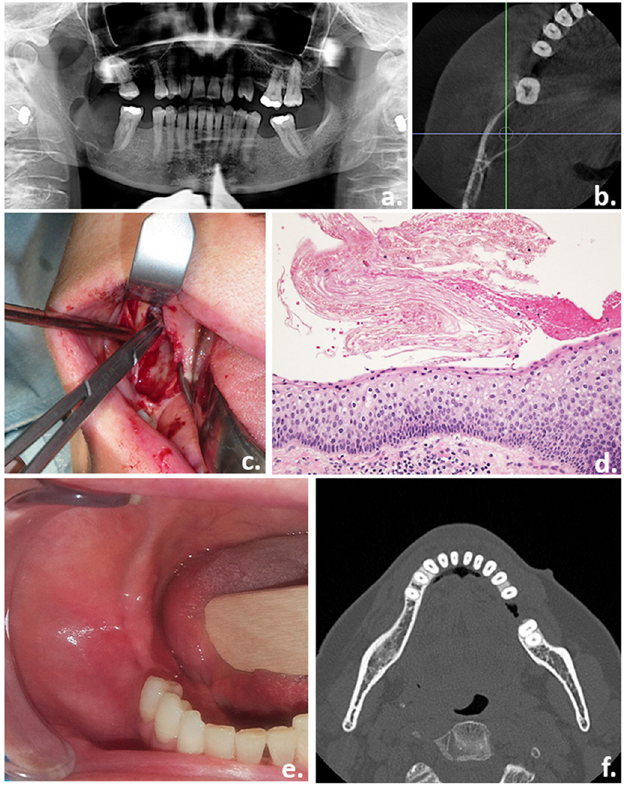
Fig. 3. Case presentation of a patient affected by OKC that didn ’ t experience recurrence: (a,b) radiological features of OKC; (c) bone cavity after OKCs removal with simple enucleation and curettage; (d) OKC features at hematoxylin and eosin staining; (e,f) clinical and radiological features showing absence of OKC